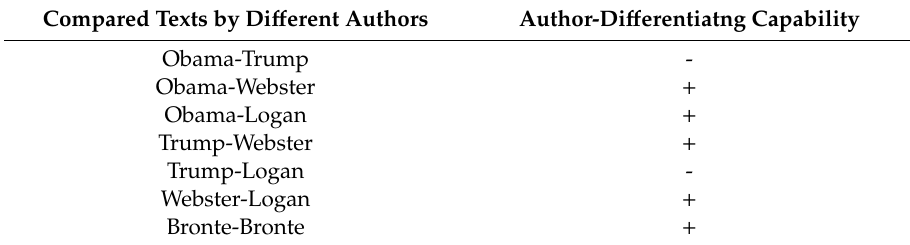
Table 2. The author-di ff erentiating capability of the nasal phoneme group.